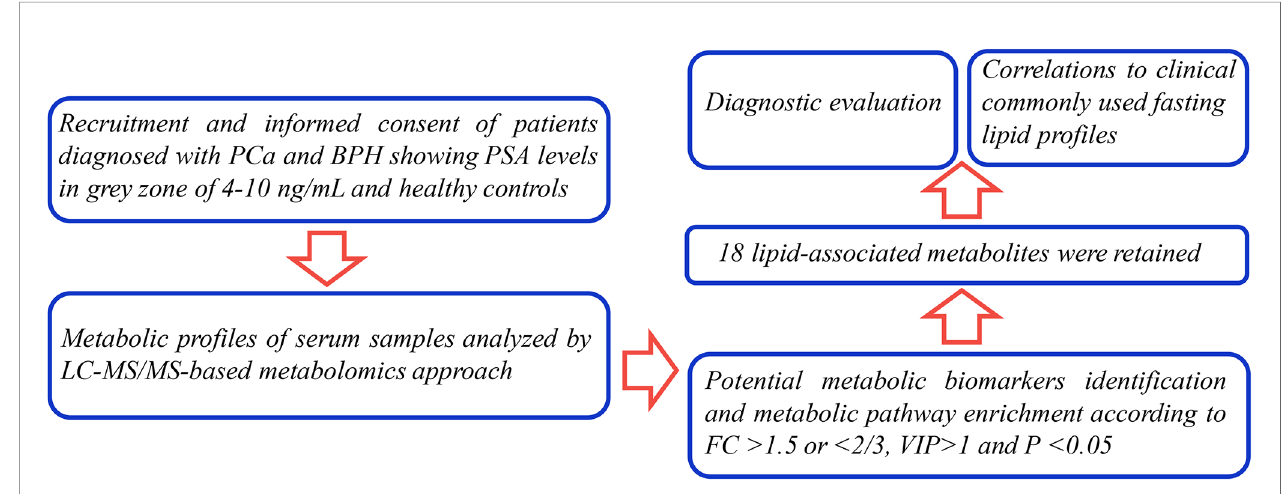
FIGURE 1 | The work fl ow of the analysis steps.